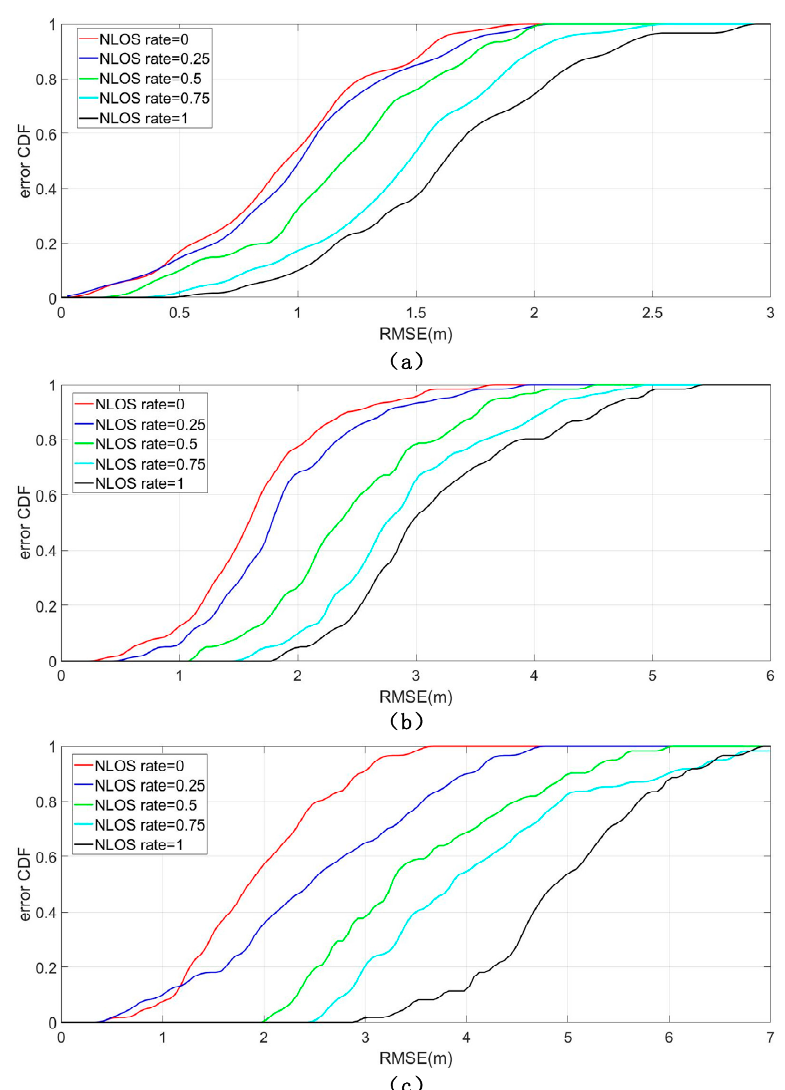
Figure 12. The CDF of ( a ) PPSA algorithm; ( b ) trilateration + PDR; ( c ) MLE + PDR in the NLOS rate of 0, 0.25, 0.5, 0.75, and 1.